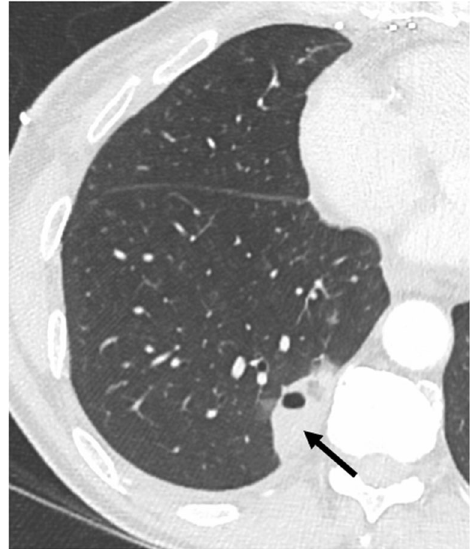
Fig. 16 Lung abscess. Fever of unknown origin and asthenia. Consolidation with air – fluid level ( arrow ) suggestive of lung abscess. Methicillin-susceptible S. aureus (MSSA) infection was confirmed by bronchoalveolar